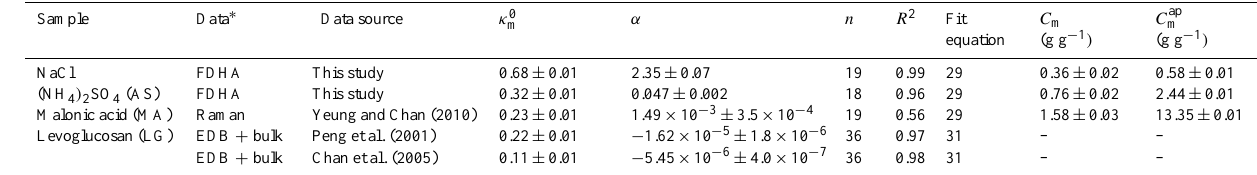
= 0 . 32 corresponds to J 0 = 2 . 35 Figure 2c and d show the mass-based hygroscopicity pa- 2 . 165 g cm − 3 ) . For AS, κ 0 m = 0 . 57 (Eq. 7 with ρ = 1 . 769 g cm − 3 ) , which is rameters ( κ m ) plotted against the mass growth factors mea- and to κ 0 d v sured for NaCl and AS. The κ m values were calculated as consistent with Petters and Kreidenweis (2007) and calcula- specified in Appendix C. We used the KIM model Eq. (29) tions based on a CCN experiment and the Aerosol Inorganic model (AIM) (Rose et al., 2008). for single solute systems to fit the data points for fully deli- By inserting κ 0 and α from Table 3 in Eqs. (29) and (12), quesced NaCl and AS (solid black lines), and the obtained m best fit parameter values and standard errors of the mass- we obtained the KIM model results displayed in Fig. 2a and based dilute hygroscopicity parameter κ 0 and of the solute b (solid line). For both NaCl and AS, the KIM two parameter m model is in good agreement with the measurement data as interaction parameter α are listed in Table 3. For NaCl, the = 0 . 67 corresponds to a dilute van’t best fit value of κ 0 well as with the much more complex AIM multi-parameter m model (dashed Hoff factor J 0 = 2 . 17 (Eq. 8) and to a volume-based di- = 1 . 45 (Eq. 7 with ρ = lute hygroscopicity parameter κ 0 d v